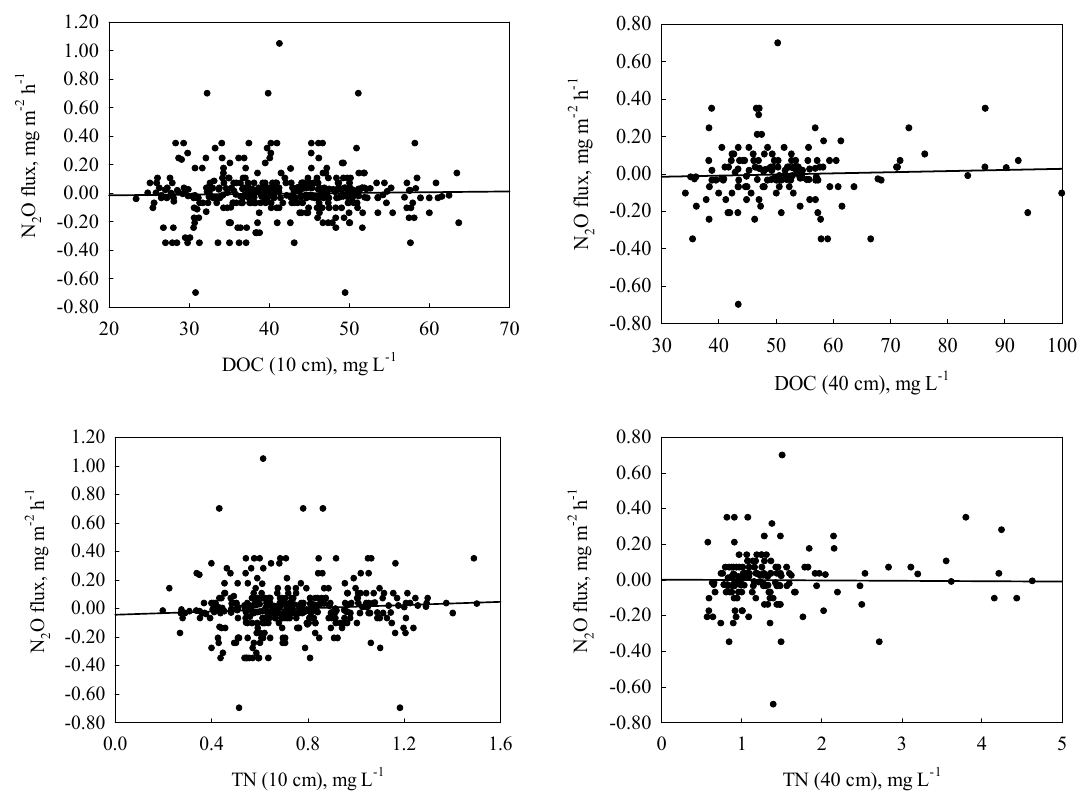
Figure 5. Linear regression between N 2 O flux and soil temperature at 0.05 m and 0.2 m depths, soil moisture, water table depth (WTD), dissolved organic carbon (DOC), and total nitrogen (TN) in the water at 0.1 m and 0.4 m depths during the growing seasons of 2015 and 2016.